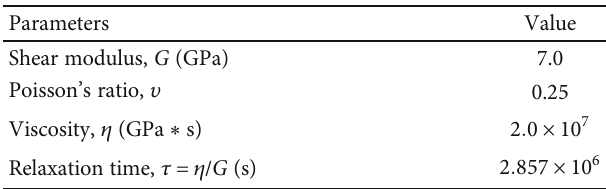
Table 4: Input parameters for the Maxwell model (see Section 3 for the model